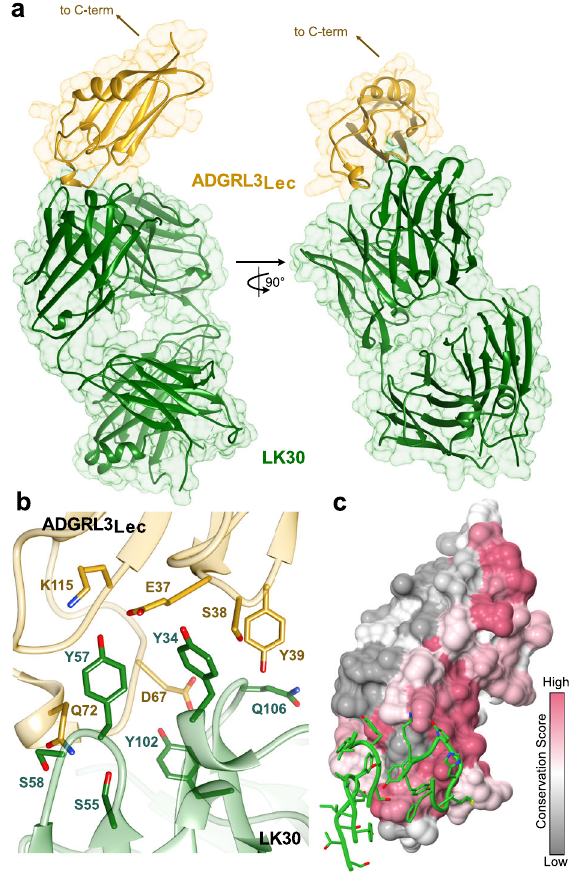
Fig. 3 | Crystal structure of the LK30/ADGRL3 complex at 2.65Å resolution. a The crystal structure of the ADGRL3 lectin domain in complex with LK30. ADGRL3 Lec is colored yellow while the HC and LC of LK30 are colored green. b Close-upviewoftheADGRL3 Lec /LK30interface.Residuesatthebindinginterface are shown as sticks. ADGRL3 Lec is colored yellow while the LK30 is colored green. c Surface conservation analysis (gray, variable; red, conserved) of the ADGRL3 Lec domain. The CDRs of the LK30 HC interacting with the Lec domain are shown in